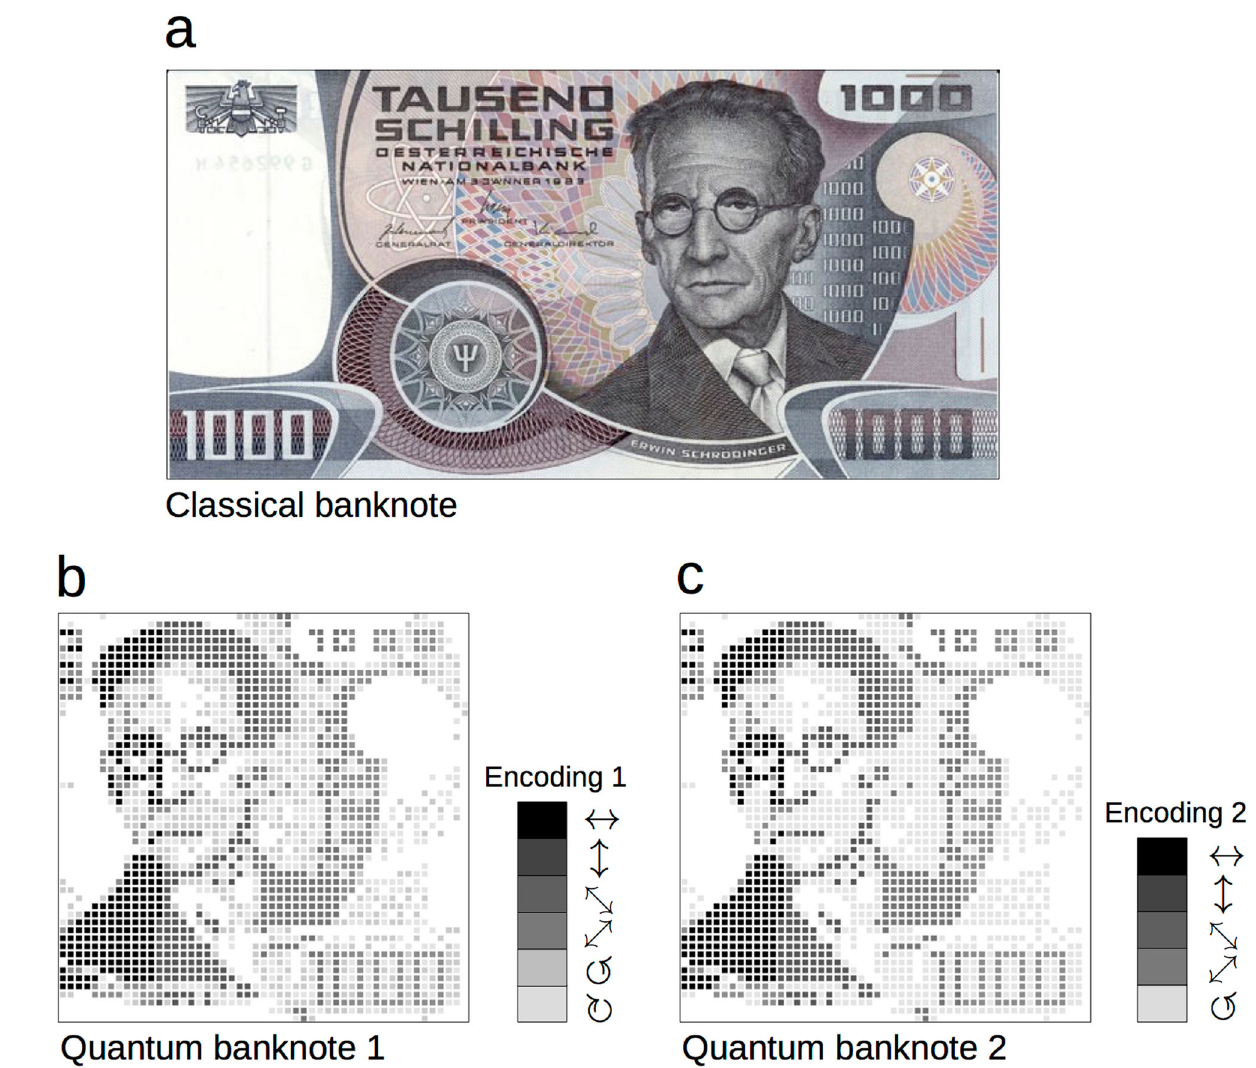
Fig. 1 An illustrative example of a a classical banknote. In panels b and c , the simpli fi ed banknote from panel a with the decreased number of colors and resolution is encoded experimentally in two ways to form two examples of quantum banknotes. The symbols used here correspond to different linear ( ↔ , l , … ) and circular ( ↺ and ↻ ) photon polarizations (as explained in the main text). Note that the white regions in b and c correspond to the lack of